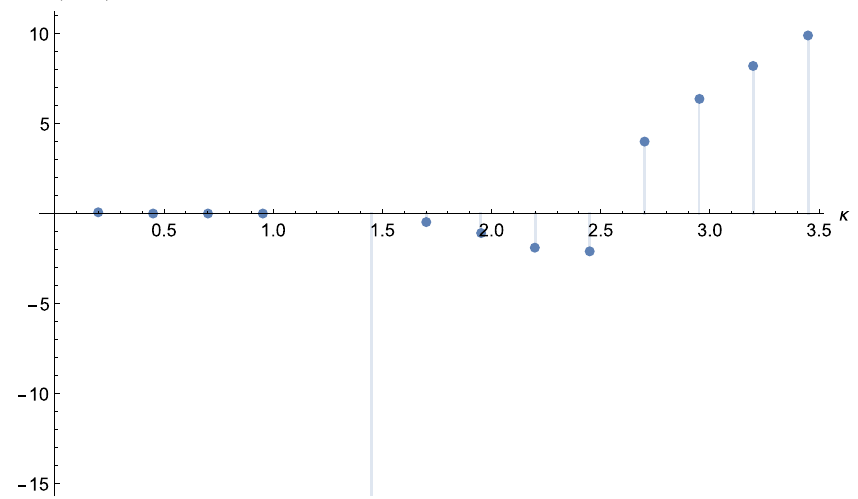
Fig. 3 Behaviour of arcsinh ( det A (κ)) as a function of κ for the fourth solution of 4 dimensional hyperbolic case, denoted 4 H δ . For clarity, we plot arcsinh ( det A (κ)) in order to limit the range of values